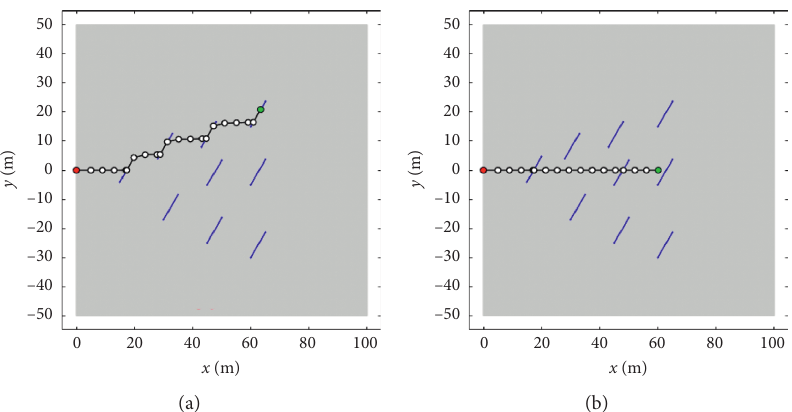
Figure 9: Intersection results based on Blanton’s criterion under different in situ principal stress difference conditions. (a) In situ principal stress difference is 2MPa; final fracture, 60 ° . (b) In situ principal stress difference is 4 MPa; final fracture, 60 °